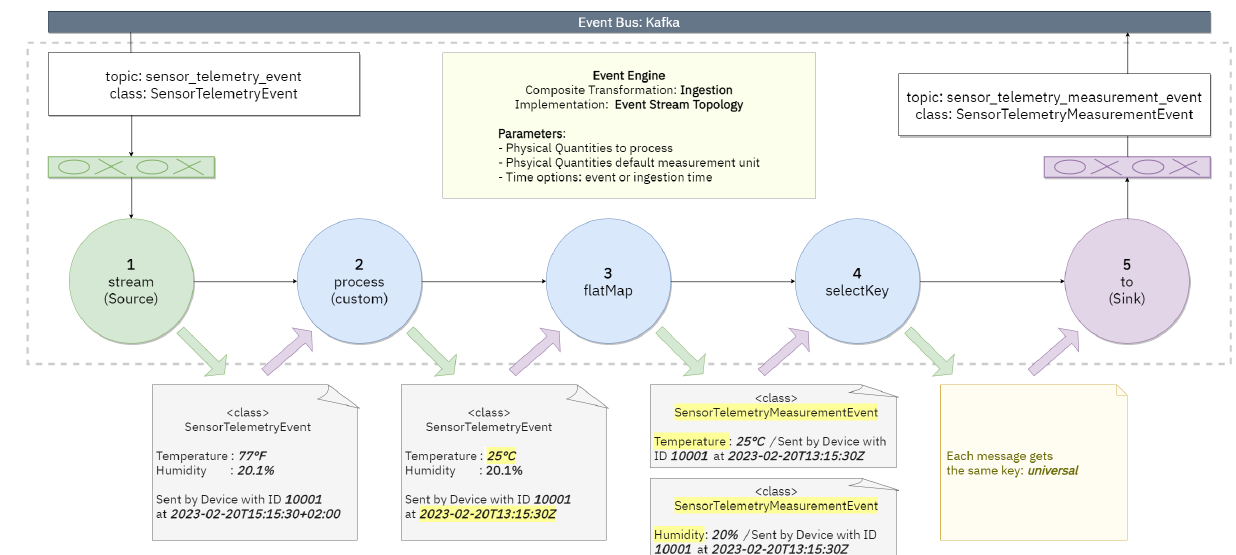
Figure 3. Event processor topology of Ingestion Composite